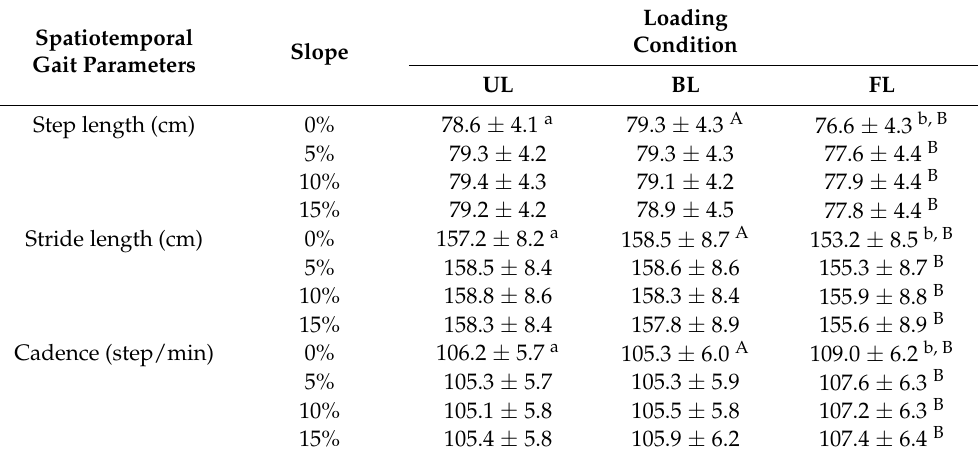
Table 2. Means ± standard deviations of spatiotemporal gait parameters during unloaded (UL), back-loaded (BL), and front-loaded (FL) gait at 0% (level), 5%, 10%, and 15% uphill slope.